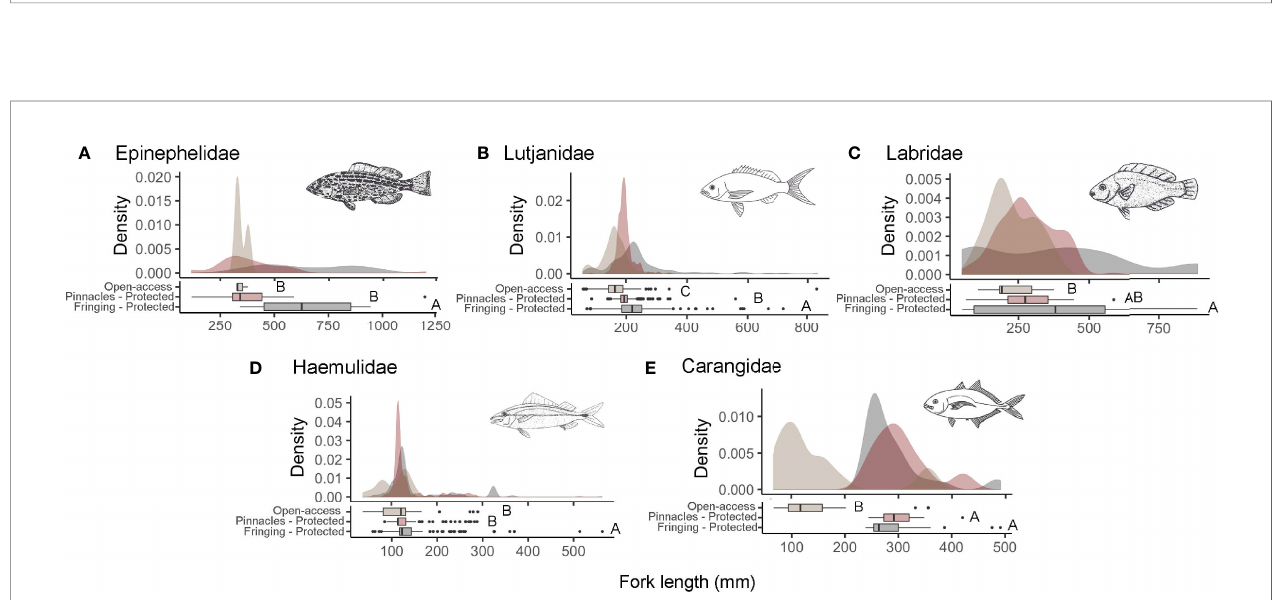
FIGURE 5 | Most parsimonious models for the biomass (grams) of fi sh families with high economic value in the region: Carcharhinidae (A) , Epinephelidae (B) , Labridae (C) and Lutjanidae (D) . Each dot represents a sample, in which the gray dots represent the Fringing Reefs, red dots the Pinnacles Reefs, and beige the Coastal Reefs.